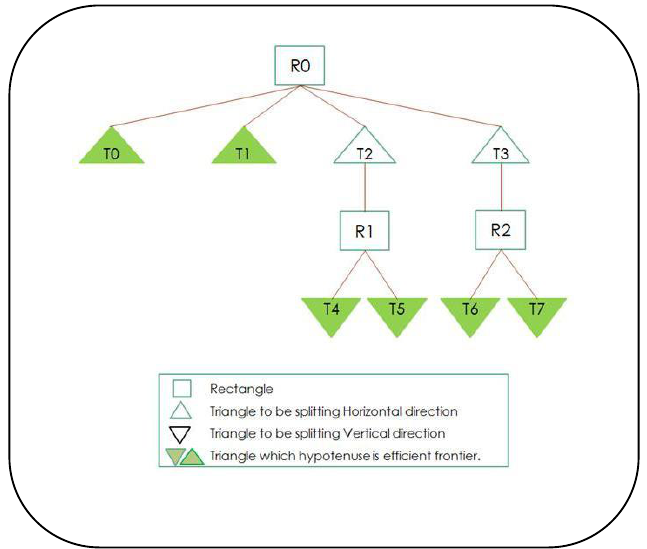
Fig. 3. Search tree of the